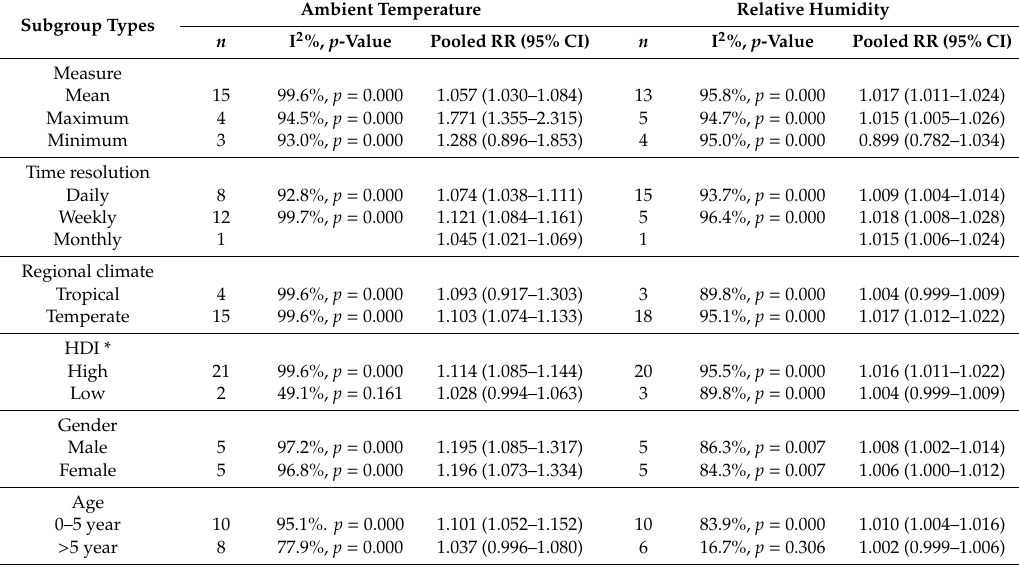
Table 2. Subgroup analysis for the increased HFMD risk associated with ambient temperature and relative humidity based on single-day lag models.